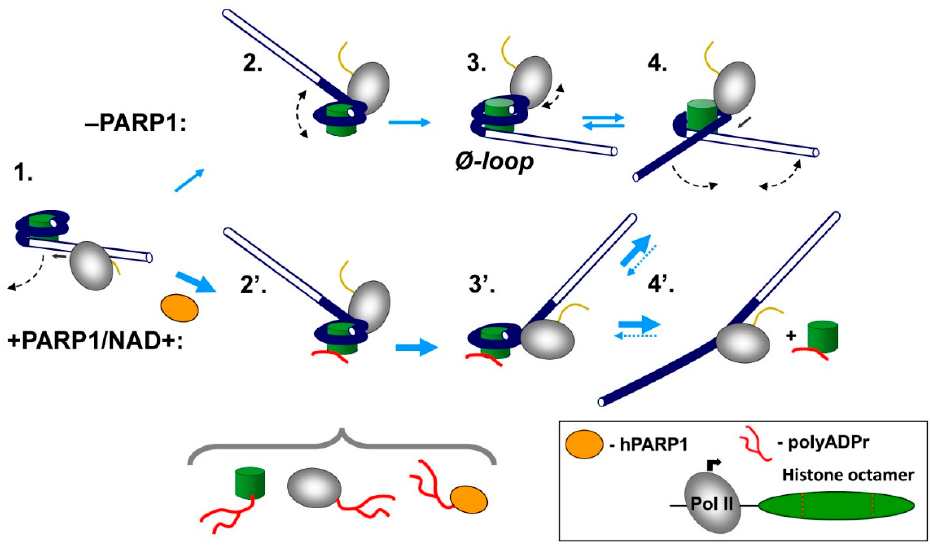
Figure 6. Proposed mechanisms of PARP1-dependent transcription through a nucleosome. Pol II transcription through the nucleosome in the absence of PARP1 (complexes 1 to 4 [28]) is accompanied by initial partial uncoiling of nucleosomal DNA from the octamer in front of Pol II (complex 2), re-coiling of nucleosomal DNA behind the transcribing enzyme with formation of a small transient intranucleosomal DNA loop (Ø-loop, complex 3), and subsequent partial uncoiling of nucleosomal DNA in front of the enzyme (complex 4). Intermediates 2 to 4 are formed during transcription through the +(35–55) region of nucleosomal DNA [28,43] that is most affected in the presence of PARP1/NAD+. Since PARP1 could PARylate itself and each protein complex present during transcription in vitro (core histones and Pol II [9,37] ), three mutually non-exclusive scenarios are possible. In each of them negatively charged PAR attached to a protein interacts with transiently exposed, positively charged surface of the histone octamer, preventing the re-coiling of nucleosomal DNA and formation of the intranucleosomal DNA loop (complexes 2 ′ and 3 ′ ). As a result, in the presence of NAD+ and PARP1, the PARylated protein(s) facilitate transcription through the nucleosome and histone eviction (complex 4 ′ ).